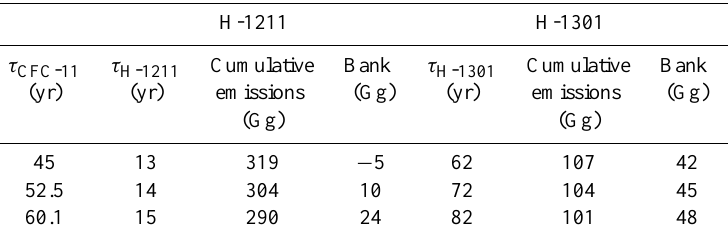
Table 5. The effect of using different CFC-11 lifetimes to calculate the stratospheric lifetime of H-1211 and H-1301 (using the Laube et al. (2013) method – Sect. 8.2) on the total lifetimes, cumulative emissions and remaining banks of H-1211 and H-1301.